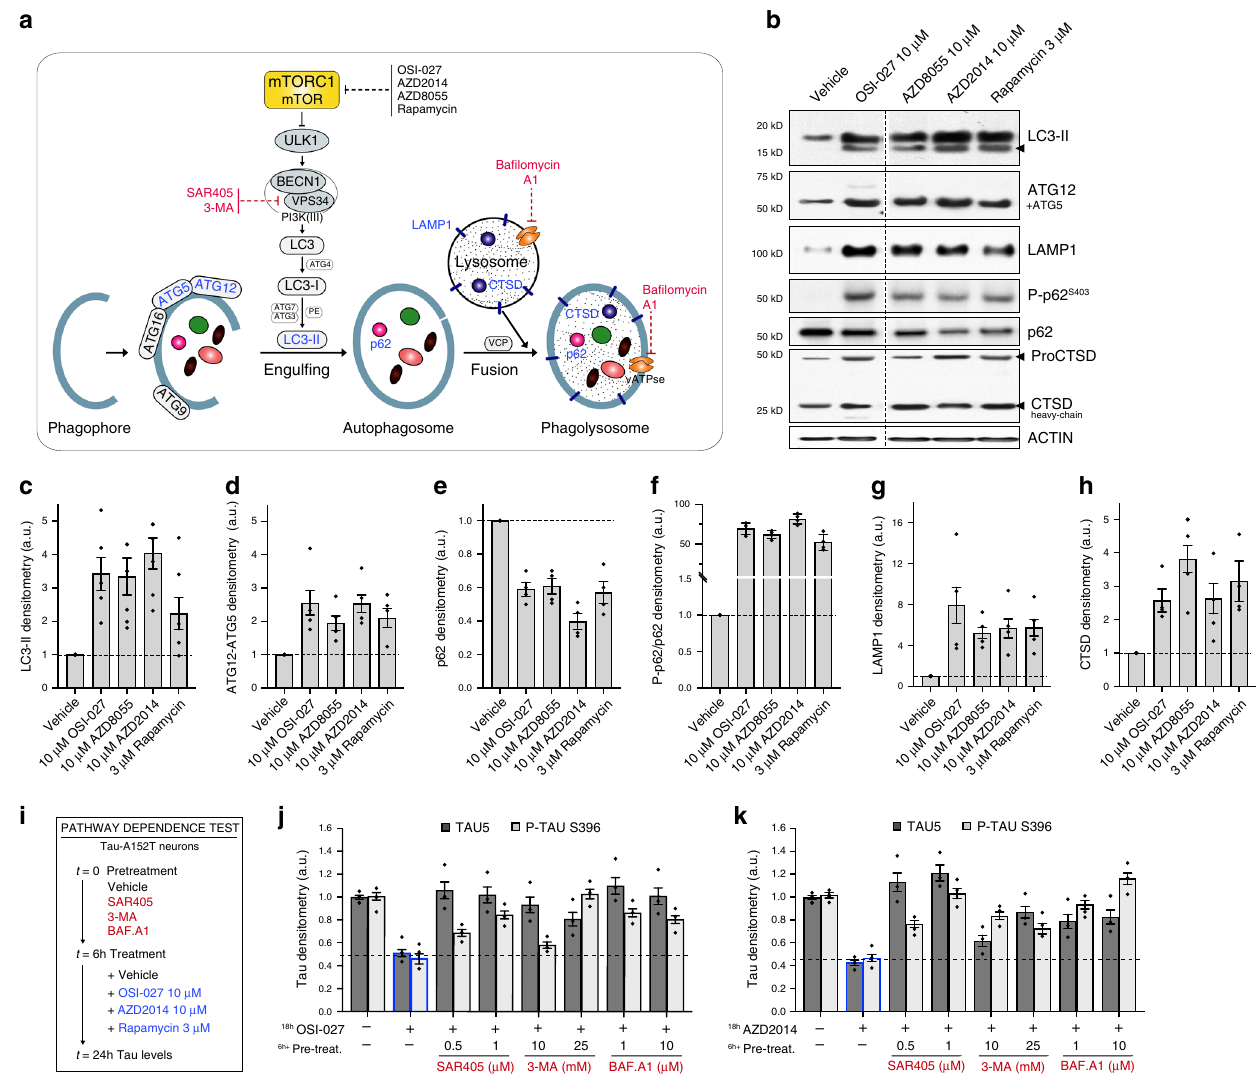
Fig. 4 Compound activation of autophagy as shown by upregulation of pathway-speci fi c markers and pathway-dependence analysis. a Simpli fi ed schematic of the proposed mechanism for mTORi-mediated tau clearance through autophagy. mTORi are shown in black, and autophagy inhibitors in red. b Western blot of autophagy-speci fi c markers (in blue, a ) in A152T neurons (6-week differentiated, FTD19-L5-RC6) upon 24 h treatment (samples were run on the same gel, image was cropped on the dotted line only for the purpose of this fi gure). Blot is representative of n = 4 biological replicates. c – h Graph bars represent mean densitometry relative to vehicle ± SEM, and black diamond-dots indicate individual data points for n = 4 biological replicates ( n = 5 for LC3-II). i Assay to test mTORi effect pathway-dependence: A152T (FTD19-L5-RC6) neurons were treated for 6 h with autophagy inhibitors (SAR405, 3-MA, BAF.A1) followed by mTORi (10 μ M OSI-027, 10 μ M AZD2014) for a total of 24 h. j , k Western blot densitometry of total tau (TAU5) and P-tau S396 levels. Graph bars represent mean tau densitometry ± SEM and black diamond-dots indicate individual data points for n = 3 biological replicates. Corresponding representative blots are included in Supplementary Fig. 5b, c. Source data are provided as a Source Data fi